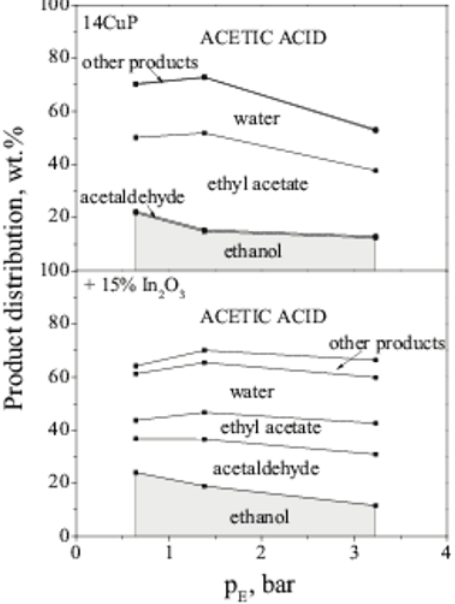
Figure 6. Product distribution of 14CuP and 15In catalysts in the conversion of AA/H of hydrogen partial pressure at 21 bar total pressure and 340°C. The WHSV of AA was 1.0 h -1 . Constant partial pressure of AA was 2.1 bar. Hydrogen partial pressure was changed by changing the H